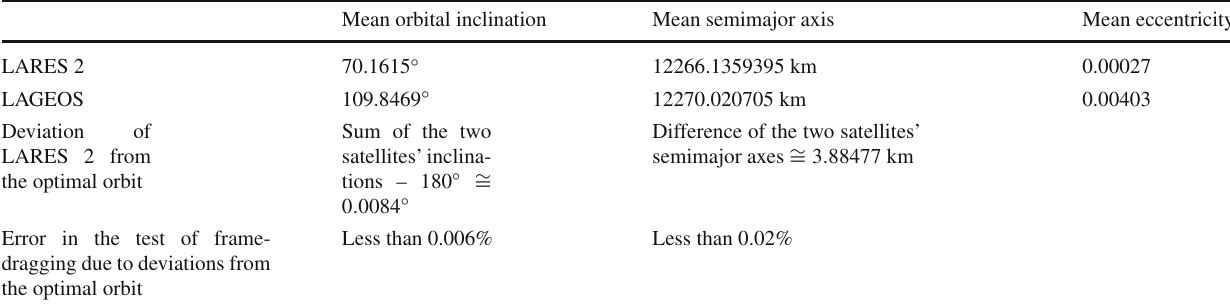
Table 1 Mean of the orbital elements of LARES 2 and LAGEOS over 127 days and the estimated corresponding error in measuring frame-dragging due to the Earth even zonal